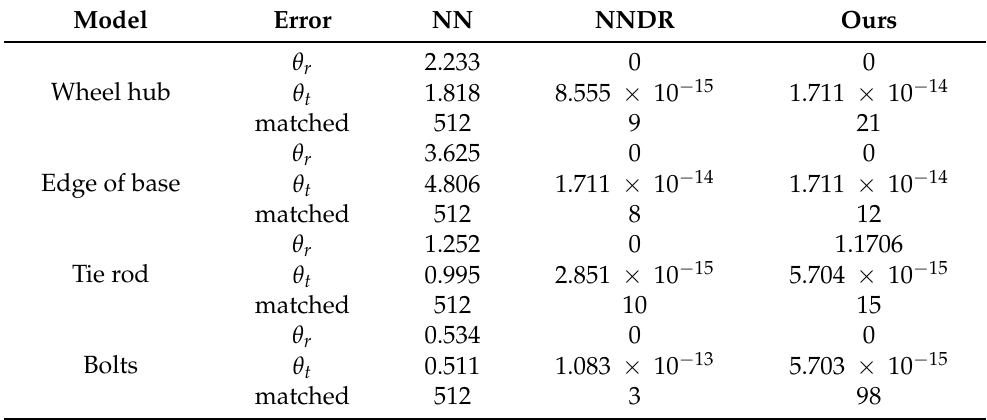
Table 3. Errors of the real